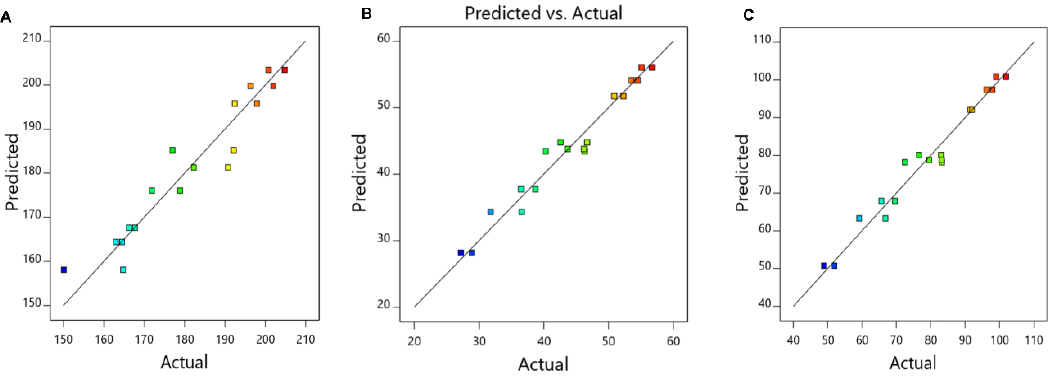
Figure 1. Graphical plots of the experimental values versus the model predicted values for ( A ) mean size, ( B ) EE for TMZ, and ( C ) EE for O6BG. Red dots indicate high values and blue dots low values, respectively.